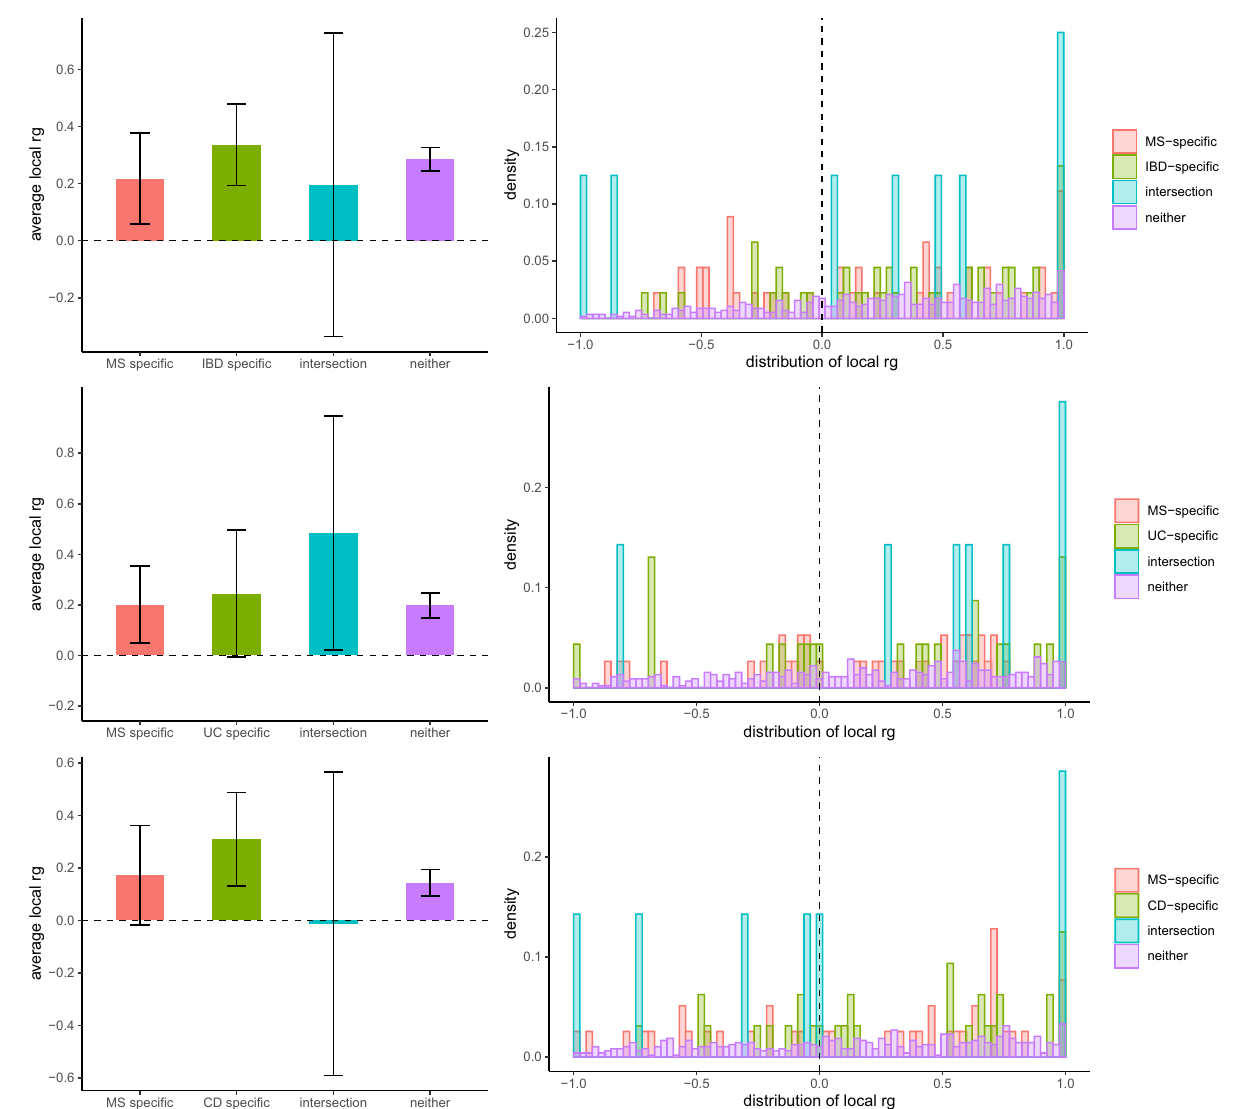
Fig. 2 Local genetic correlations ( r g ) between multiple sclerosis (MS) and in fl ammatory bowel disease (IBD; top), ulcerative colitis (UC; middle) and Crohn ’ s disease (CD; bottom), respectively. Left: average local r g estimates for each disease pair in regions harbouring disease-speci fi c risk variants ( p < 5 × 10 − 8 ), regions harbouring shared risk variants ( “ intersection ” ) and all other regions ( “ neither ” ). Local genetic correlations with estimates less than − 1 or greater than 1 were forced to − 1 or 1, respectively. Error bars represent the 95% con fi dence intervals (CIs), calculated using a jack- knife method. Right: density distribution of local r g estimates for each disease pair in disease-speci fi c regions (red, green), intersection regions (blue) and other (purple) regions. For MS-IBD, 45, 45, 8, and 572 regions were included in the ‘ MS-speci fi c ’ , ‘ IBD-speci fi c ’ , ‘ intersection ’ , and ‘ neither ’ categories; for MS-UC, 38, 23, 7, and 456 regions were included in the ‘ MS-speci fi c ’ , ‘ UC-speci fi c ’ , ‘ intersection ’ , and ‘ neither ’ categories; for MS-CD, 39, 32, 7, and 480 regions were included in the ‘ MS-speci fi c ’ , ‘ CD-speci fi c ’ , ‘ intersection ’ , and ‘ neither ’ categories. Source data are provided with this (Table S8). Correlations for MS with IBD, UC and CD in per- but only marginally signi fi cant due to the modest number of cell types in this tissue ( N = 11). For comparison, the correlation of cell-type-speci fi c heritability enrichments between UC and CD was ~0.75 in lung and spleen, and ~0.55 in PBMC and small intestine – terminal ileum.